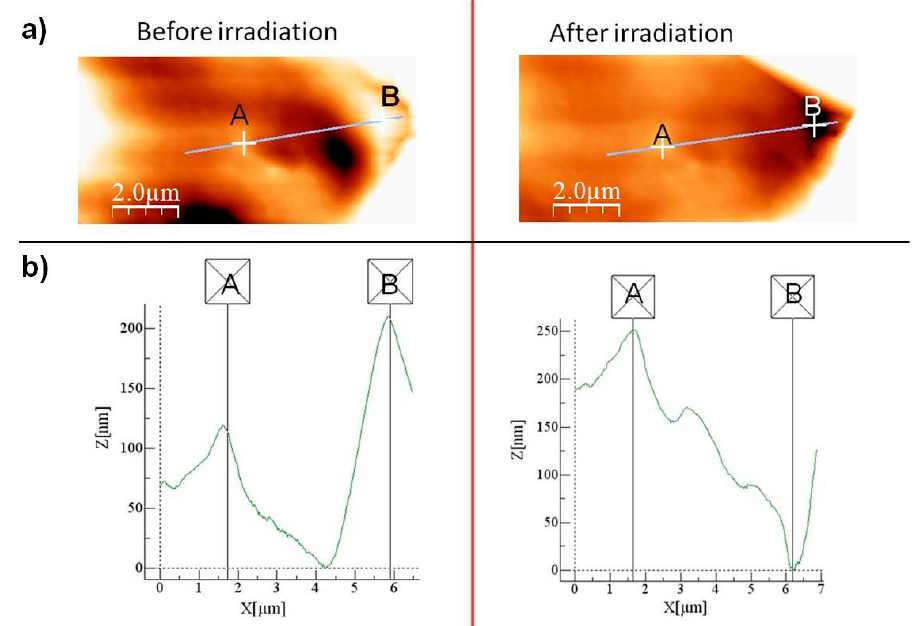
Figure 5. Atomic Force Microscope scan areas recorded in a tapping mode of sample MC3 before and after irradiation ( a ), AFM Z (height) between points A and B during irradiation of sample MC3 ( b ).